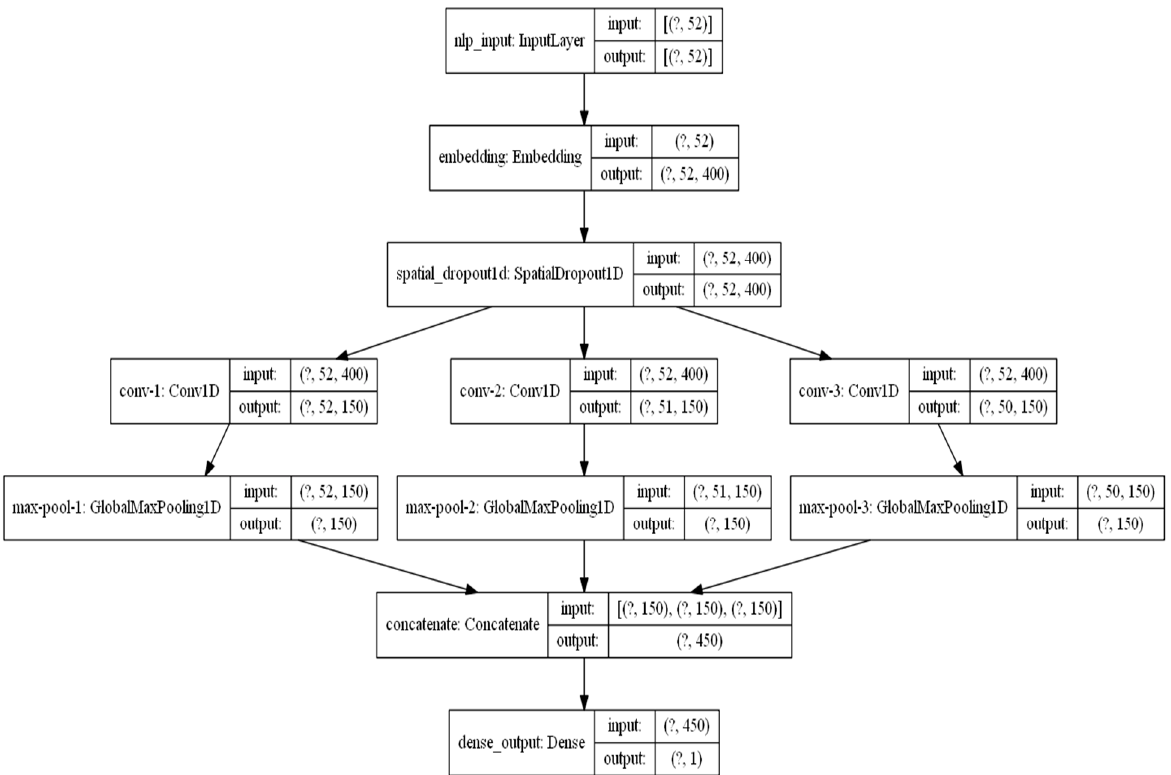
Figure 7. Architecture of the baseline: PCNN model.